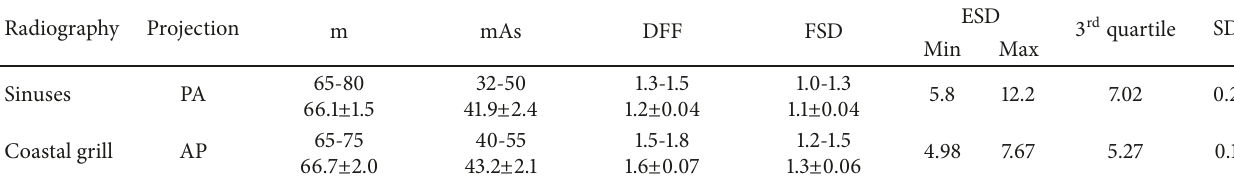
Table 3: Technical parameters used.